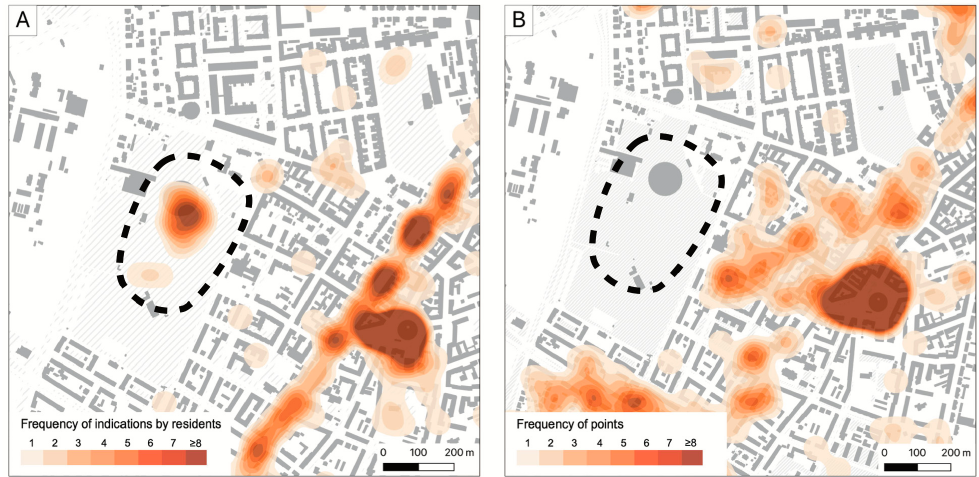
Figure 3. Comparison of places indicated by the group of residents ( A ) and urban planners ( B ) regarding areas of lack of traffic safety—“zone 30” and surroundings. The dashed black line marks the areas of difference. Source of reference data: © OpenStreetMap contributors, see: https://www.openstreetmap.org/copyright (accessed 10 February 2023).